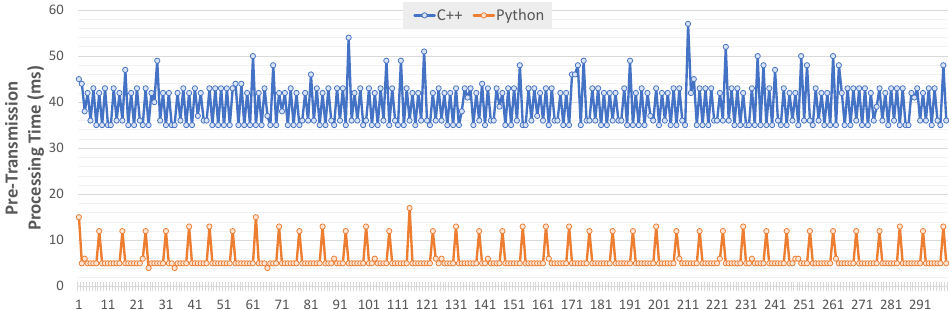
Figure 4. Processing times prior to data transmission from Unity. For C++ DLL: average, 39.46 ms; minimum, 35 ms; maximum, 57 ms. For Python MQTT: average, 6.05 ms; minimum, 4 ms; maximum, 17 ms.